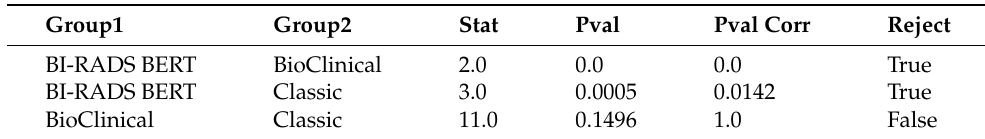
Table A19. Bonferonni-corrected McNemar test results for field extraction with no section segmenta- tion of purpose.